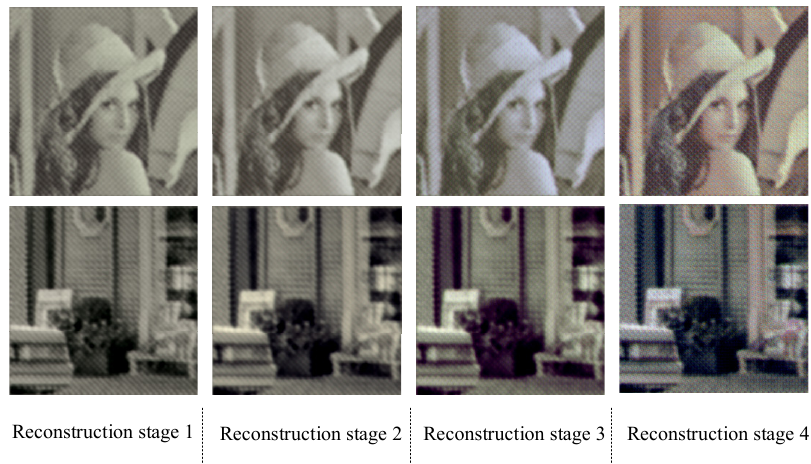
Figure 3. Illustration of the restoring images at different feature reconstruction layers.